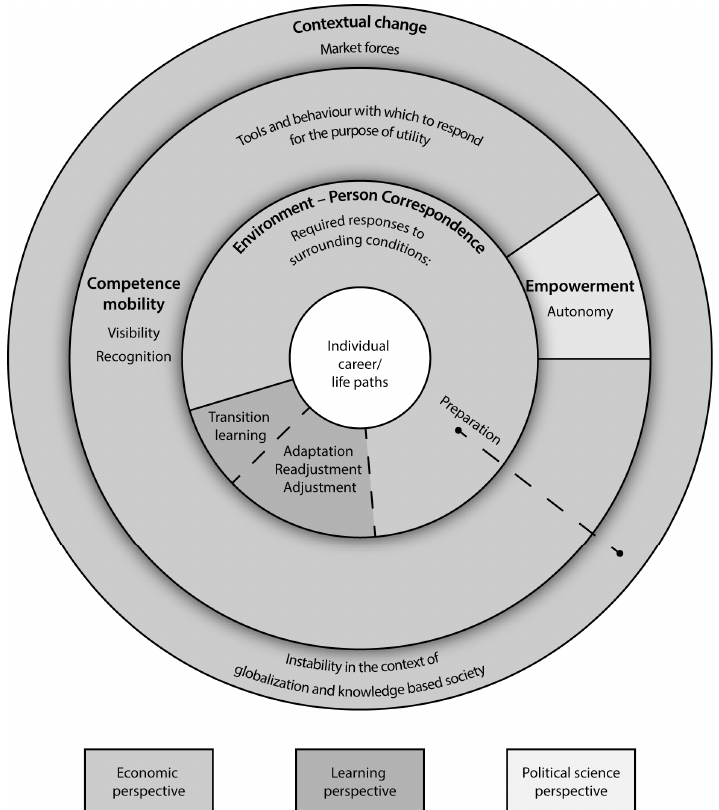
Figure 1 . Perspectives on career found in the texts analysed. Source: